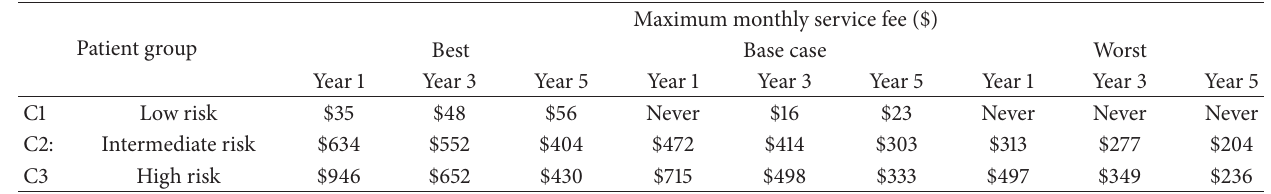
Negative delta cost indicates cost saving. Table 7: Break-even costs for different patient risk groups to reach cost saving in 1, 3, and 5 years. Patient